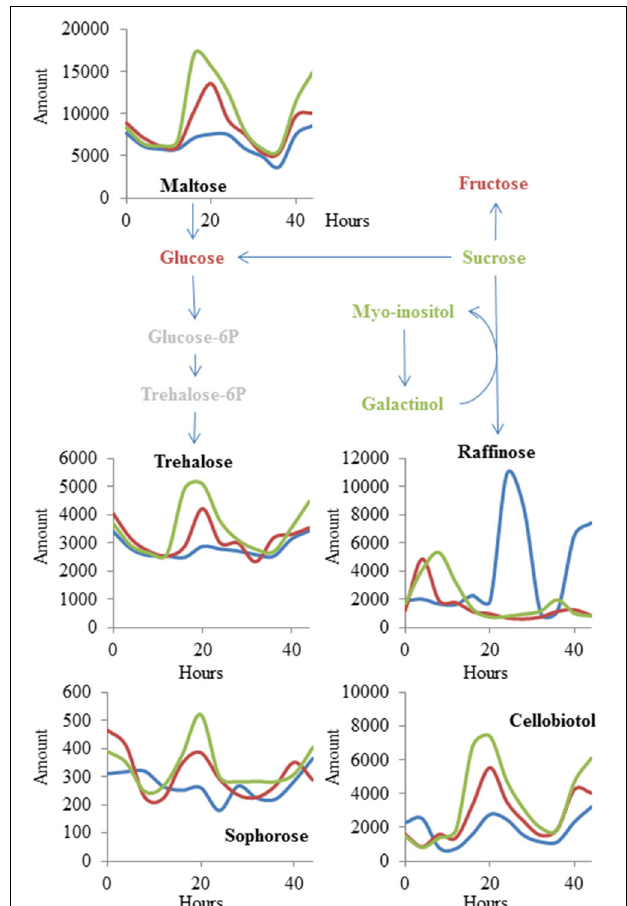
FIGURE 5 | MNM1 effects upon cycling within the metabolic network. Shown are the known metabolites that were altered in a time-dependent fashion by the mnm1-1 , mnm1-2 , and MNM1 OE genotypes in comparison to wildtype controls within the free-run experiment. The metabolites are placed within a sugar network for illustration. Red metabolites had no significant effect of MNM1 function, green metabolites had a significant effect of MNM1 function but no interaction with time and are shown in Figure 4 . Metabolites labeled in black had a significant interaction of MNM1 function and time within the analysis. Their levels are shown across the 44h of the experiment in relative abundance levels obtained from the GC-TOF analysis. Blue lines in the graph represent WT Col-0, Red lines are the effect of mnm1-1 and mnm1-2 , while green is the effect of the OE7 and OE8